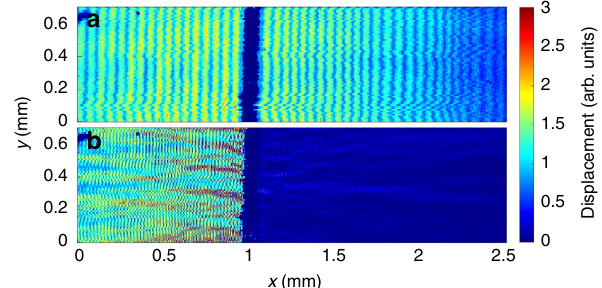
Fig. 5 Measured out of plane SAW displacement. Images of SAWs incident on fabricated PnC at a 33 MHz and b 97 MHz. The waves are excited far left of the image propagating right, the dark strip in the centre is the area of fabricated PnC. At 33 MHz the SAW propagates through, at 97 MHz